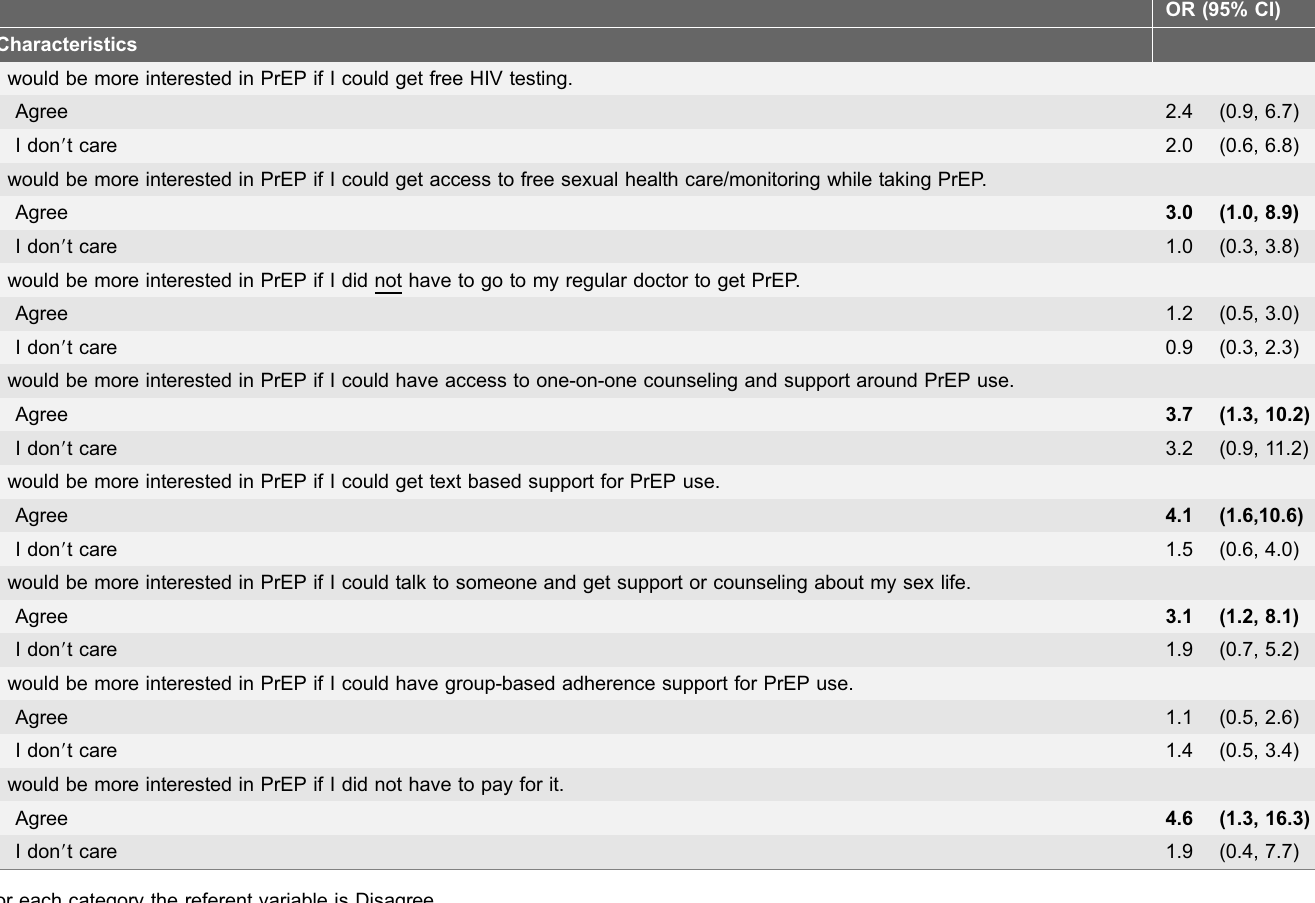
Table 4. Bivariate analysis of interest in psycho-behavioral support services and willingness to use LAI-PrEP (N 5 197).